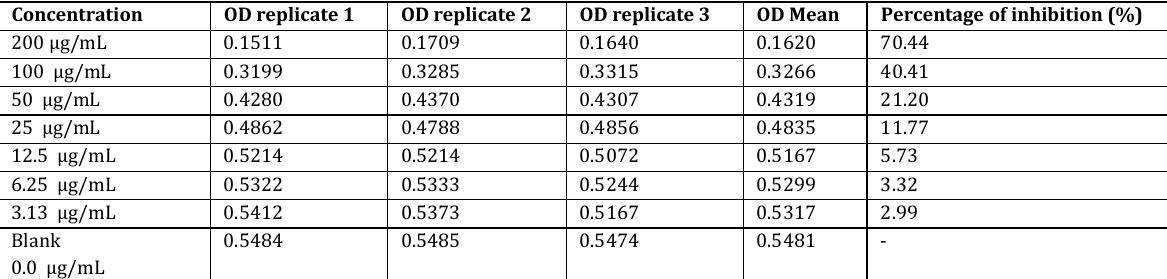
Table 3: Percentage of oxidation inhibition for old